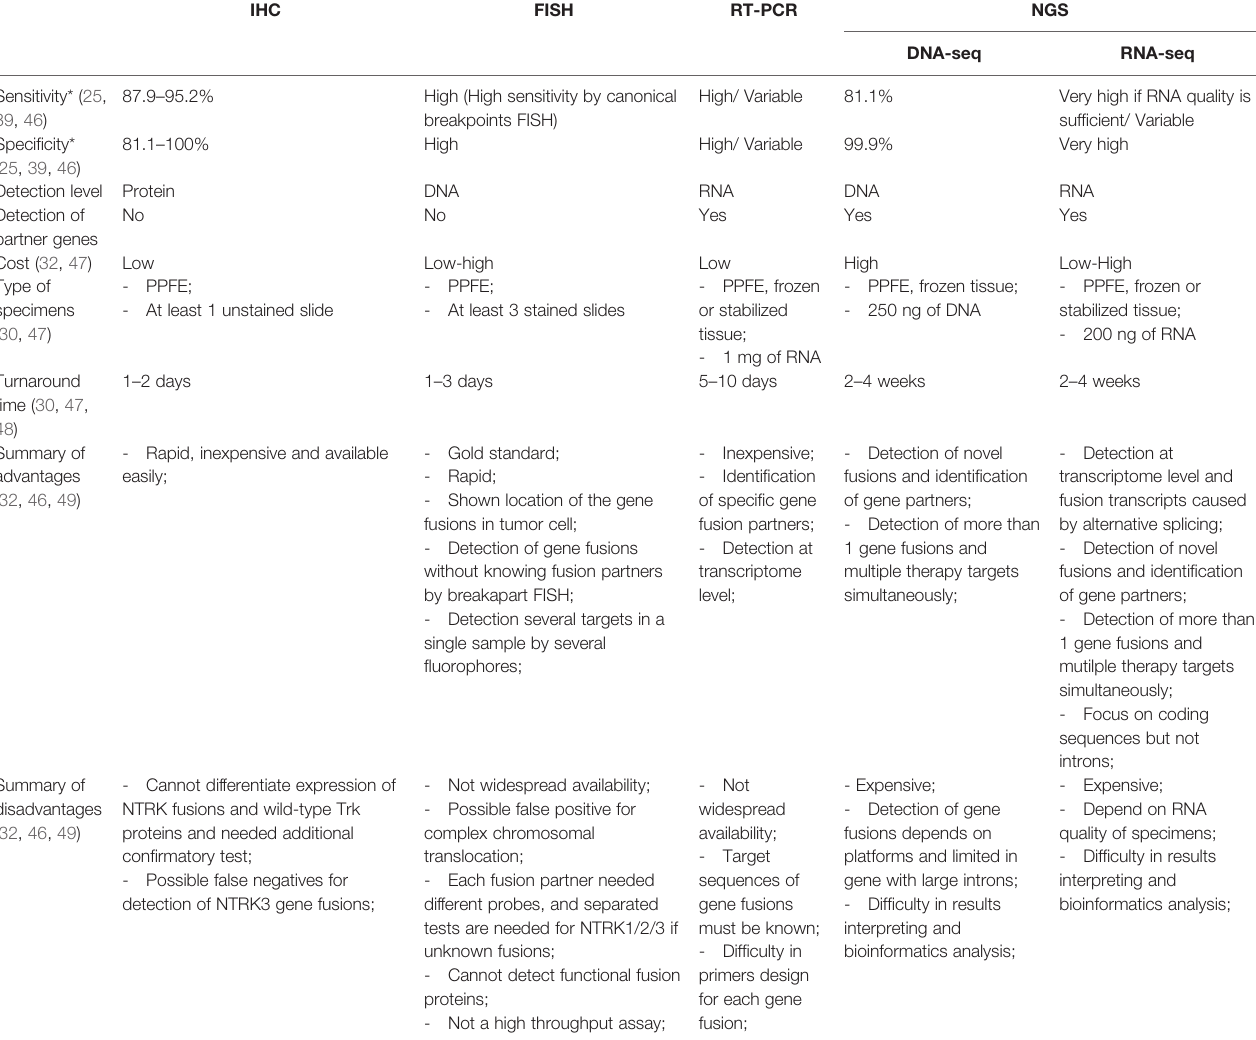
TABLE 2 | Advantages and disadvantages of NTRK detection